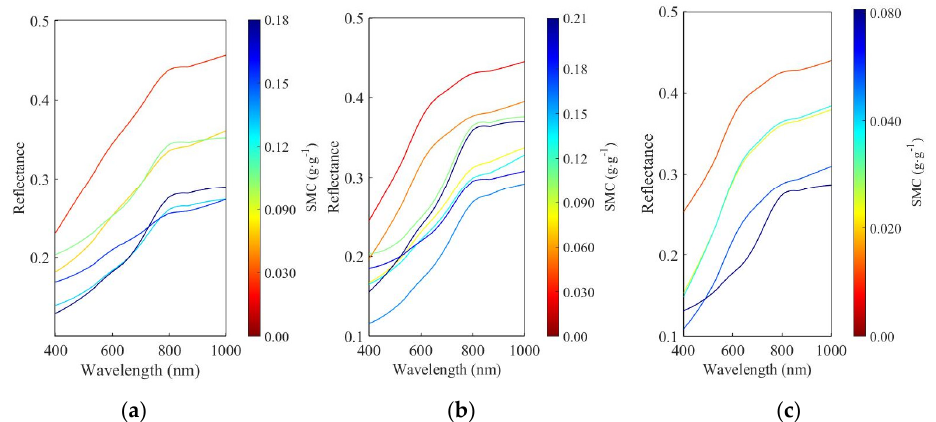
Figure 6. Variation of spectral reflectance of soils with SMC under three SSC conditions: ( a ) SSC 0.15 dS ∙ m − 1 , ( b ) SSC 0.50 dS ∙ m − 1 and ( c ) SSC 1.6 dS ∙ m − 1 .